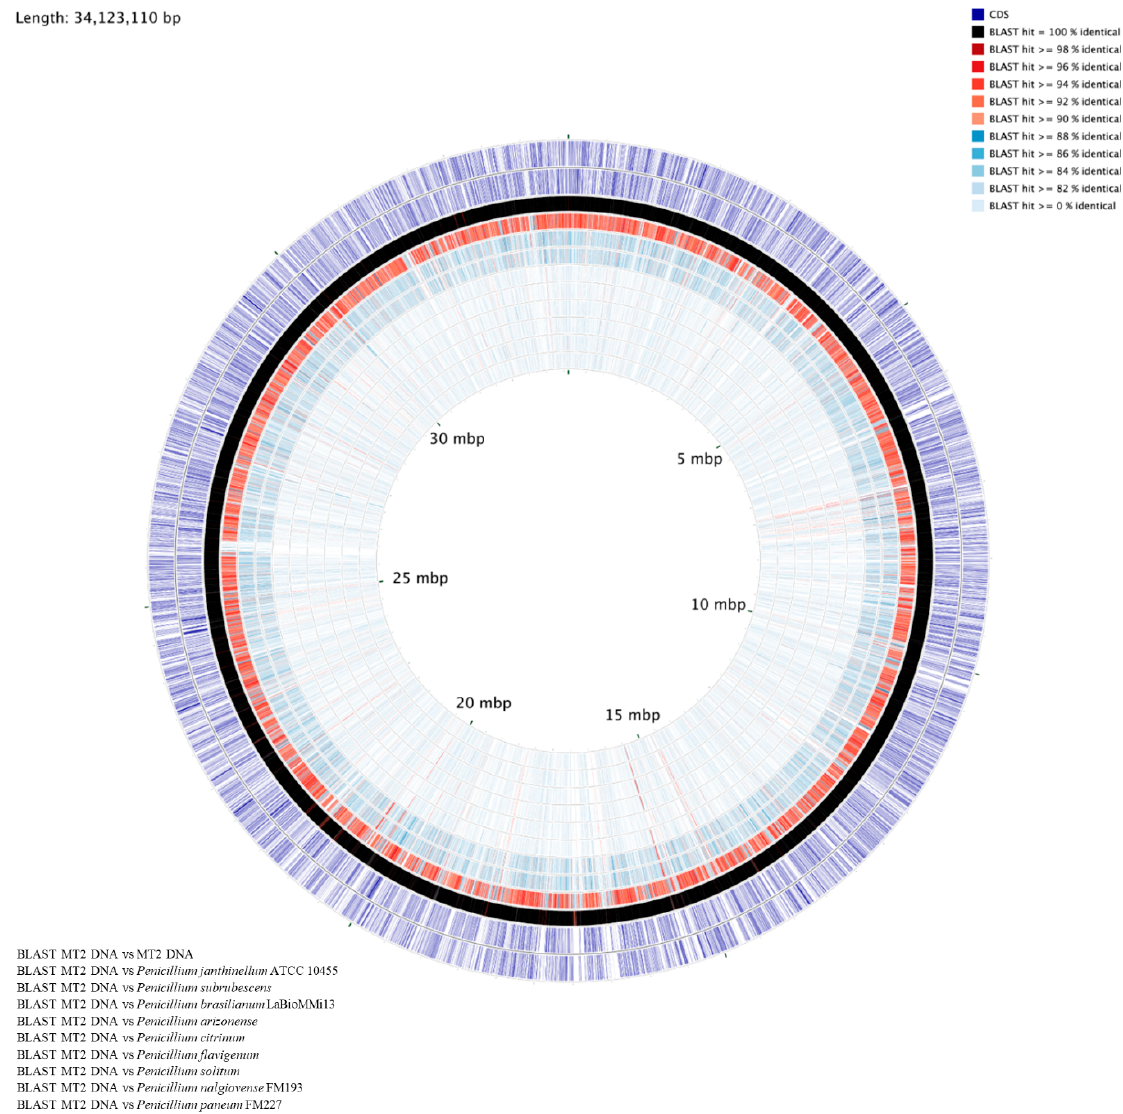
Figure 7. Shown is a circular genomic map of Penicillium sp. strain MT2. The outer two rings show the positions of CDS features on the forward and reverse strands, respectively. The remaining rings display the results of blastn comparisons between the MT2 genome and several comparison genomes, as follows: MT2, Penicillium janthinellum strain NCIM1366, Penicillium subrubescens strain CBS 132785, Penicillium brasilianum , Penicillium arizonense strain CBS 141311, Penicillium citrinum , Penicillium flavigenum strain IBT 14082, Penicillium solitum strain RS1, Penicillium nalgiovense strain IBT 13039, and Penicillium paneum FM227, respectively. For the blast comparisons, an E-value cutoff of 0.000001 was used. The map was generated using the CGView Comparison Tool, available to download from: http://stothard.afns.ualberta.ca/downloads/CCT/.